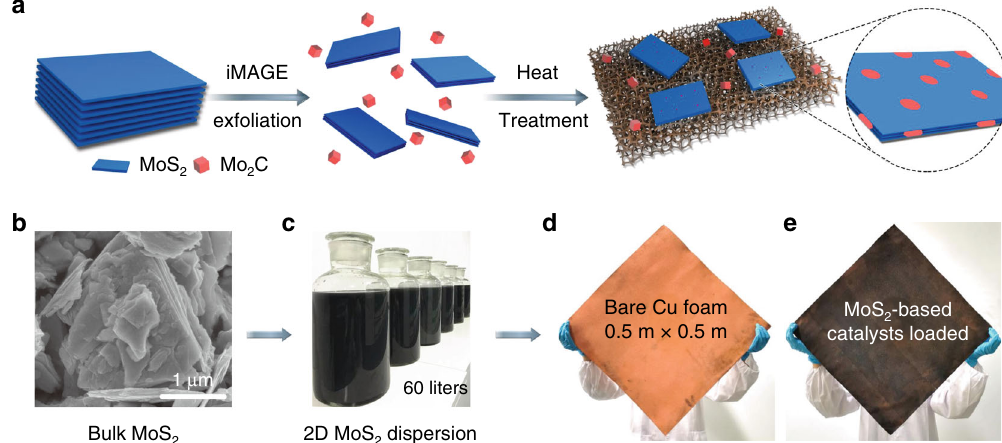
Fig. 1 High-throughput production of molybdenum disul fi de (MoS 2 )-based ink-type electrocatalysts. a Schematic of the fabrication method of MoS 2 - based catalysts. b Scanning electron microscopy image of the pristine MoS 2 powder, and photos of ( c ) two-dimensional (2D) MoS 2 aqueous dispersion with a volume of 60 liters, ( d ) bare copper (Cu) foam and ( e ) MoS 2 -based catalyst loaded on Cu